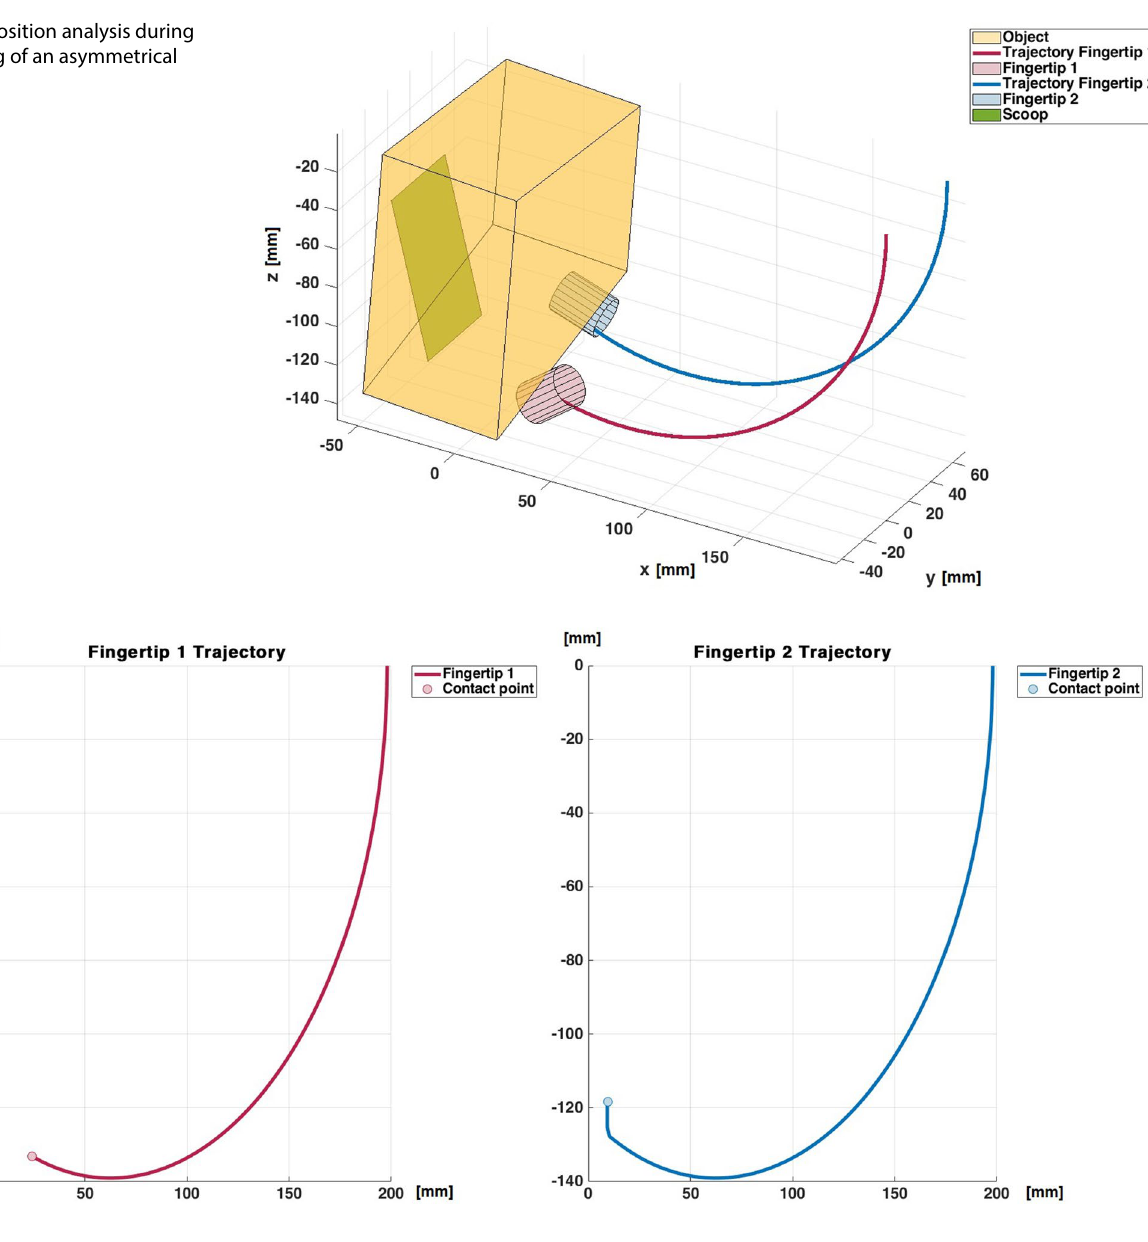
Fig. 8 2D trajectories during grasping of an asymmetrical